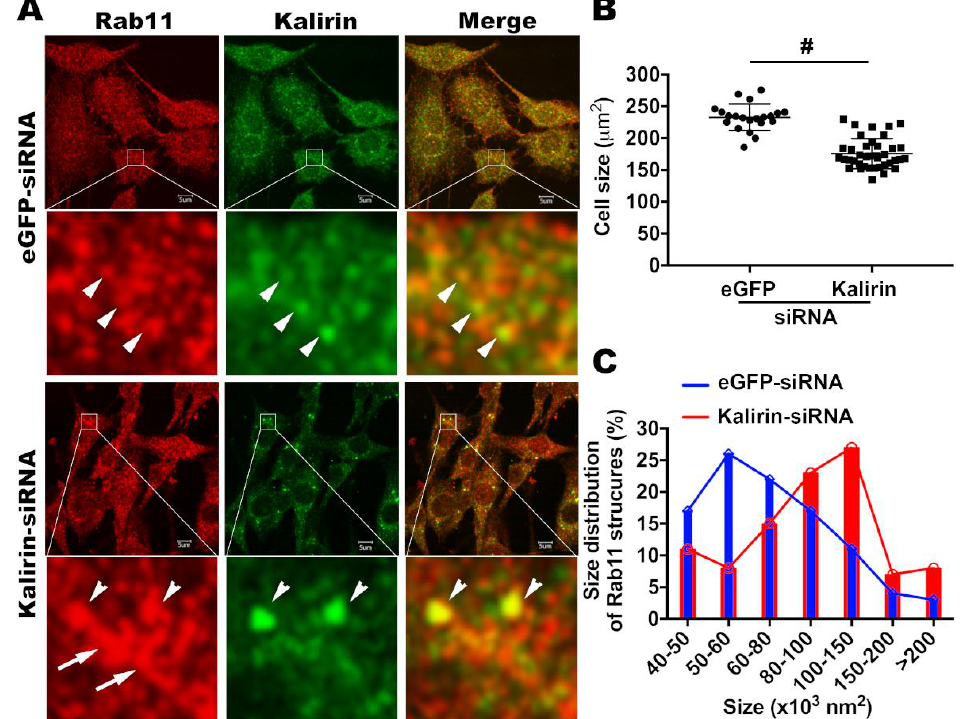
Figure 5. Knockdown of kalirin induces cell shrinkage and tubulation of recycling endosomes. NRK cells were transfected with siRNAs for eGFP or kalirin as above and processed for labeling Rab11 (red), kalirin (green), and nuclei (blue). ( A ) Confocal images show that signals for kalirin were diffusely distributed and occasionally occurred at Rab11 positive structures in NRK cells treated with eGFP-specific siRNAs, whereas kalirin signals were concentrated at large punctate structures co-labeled with Rab11 in kalirin-siRNA treated NRK cells. Boxed areas are enlarged and shown beneath the corresponding images. Arrowheads point to structures containing both Rab11 and kalirin. Arrows in the red channel of kalirin-siRNA treated NRK cells identify elongated Rab11 positive recycling endosomes, which are rarely seen in eGFP-siRNA treated cells. Scale bars: 5 µ m. ( B ) Comparison of cross-sectional areas of cells treated with eGFP-siRNA vs kalirin-siRNA. Each symbol in the plot represents one cell (Mean ± SD, Student’s t -test: #: p < 0.0001). ( C ) Comparison of Rab11 positive structures shows that there is a shift in size of Rab11 positive structures from smaller to larger ones in kalirin-siRNA treated cells relative to those in cells treated with eGFP-siRNA. Statistical significance was conducted with Chi square test for trend ( X 2 , df = 16.99, 1: p <